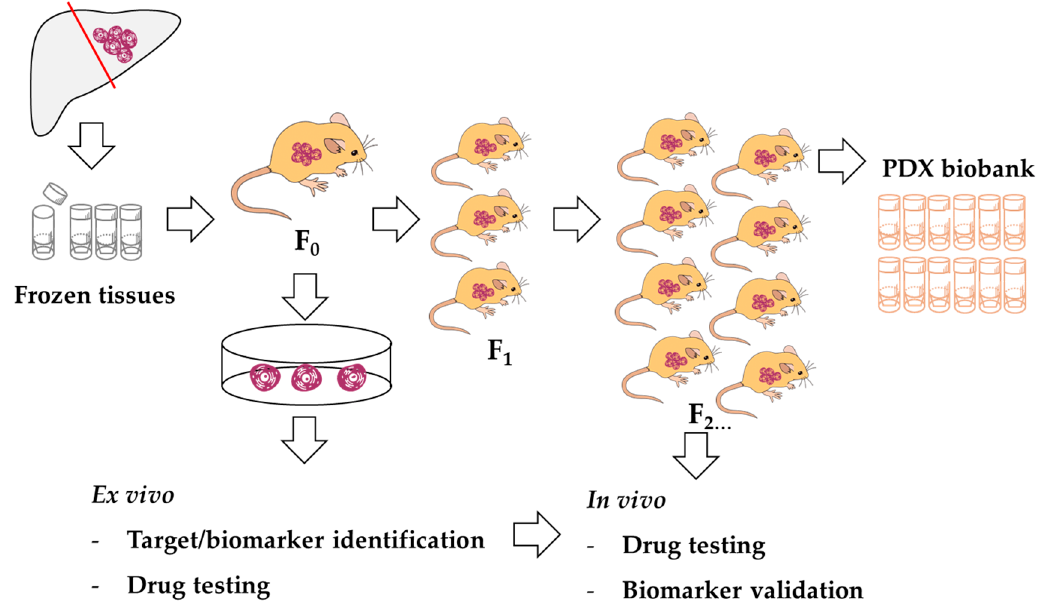
Figure 7. A proposed model of PDX resource usage.